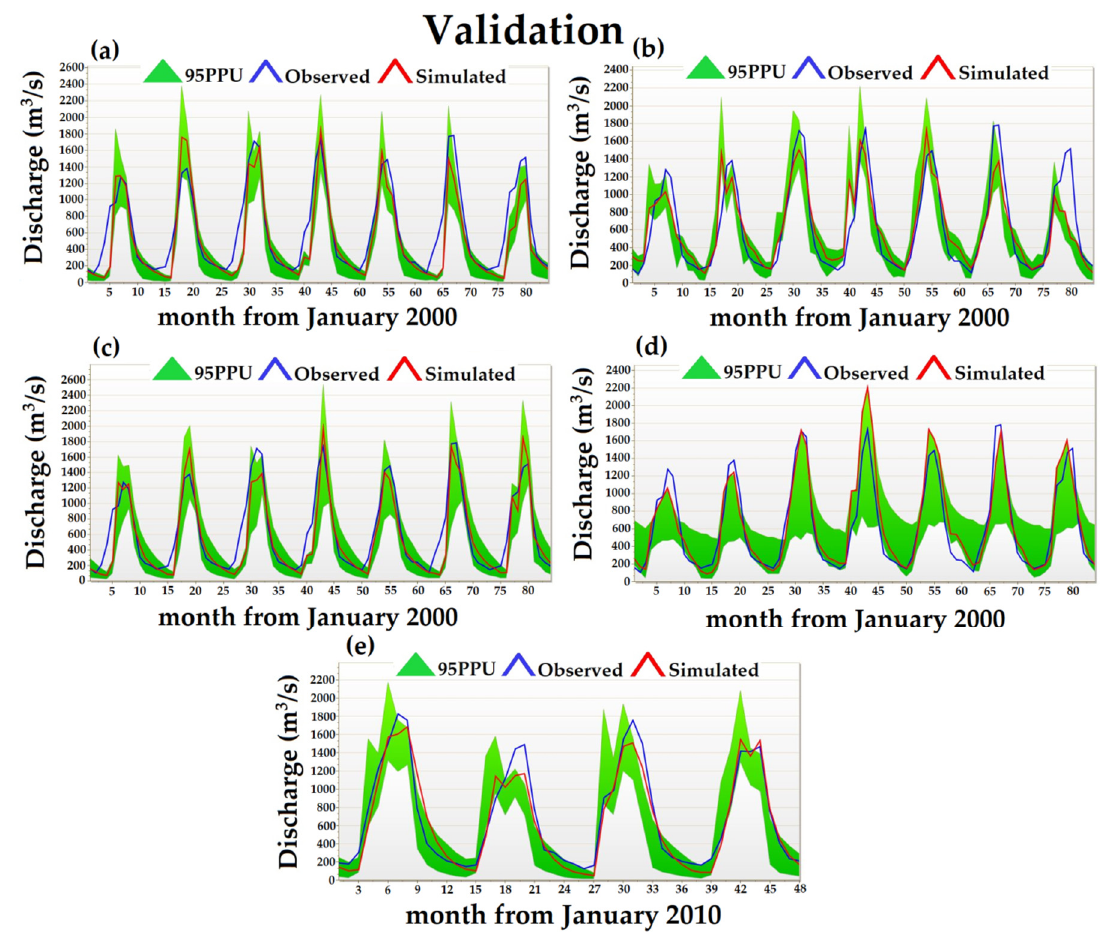
Figure 6. Hydrographic validation between monthly observed and simulated streamflow, when applying the SWAT–CUP tool, at Darband gauging station in the Upper Vakhsh River Basin in Central Asia. ( a ) Results of the daily precipitation of the APHRODITE_V1101 and daily maximum/minimum temperatures from the CFSR datasets; ( b ) results of the daily precipitation of the APHRODITE_V1101 and daily maximum/minimum temperatures of the CRU TS3.1 product; ( c ) results of the daily maximum/minimum temperatures, precipitation, average solar radiation, average wind speed and relative humidity from the CFSR product; ( d ) results of the daily maximum/minimum temperatures, precipitation from the CRU TS3.1 product; ( e ) results of the daily maximum/minimum temperatures and precipitation from the observational climate datasets.